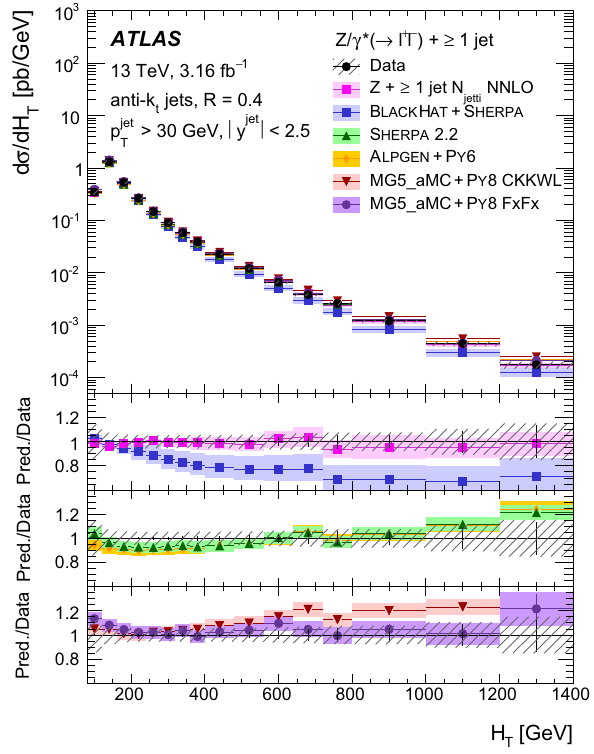
Fig. 7 Measured cross section as a function of H T for inclusive Z + ≥ 1 jet events. The data are compared to the predictions from Z + ≥ 1 jet N jetti NNLO, BlackHat+Sherpa , Sherpa 2.2 , Alp- gen+Py6 , MG5_aMC+ Py8 CKKWL, and MG5_aMC+ Py8 FxFx. The error bars correspond to the statistical uncertainty, and the hatched bands to the data statistical and systematic uncertainties (including luminosity) added in quadrature. The details of the prediction uncer- tainties are given in the